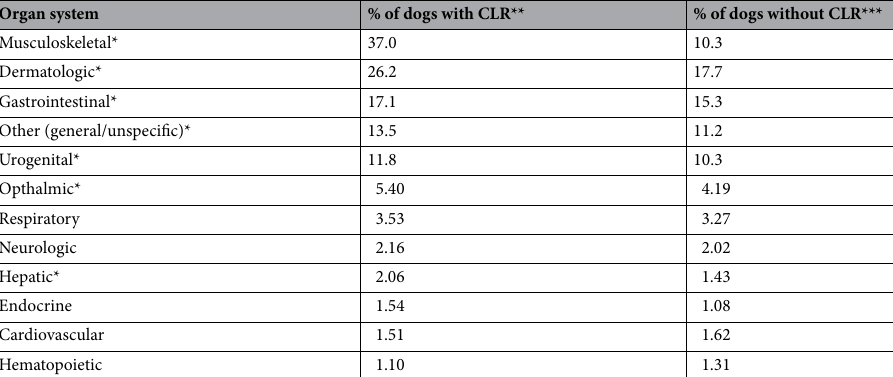
older studies, and that more recent studies, but with smaller study populations, had too low power to identify